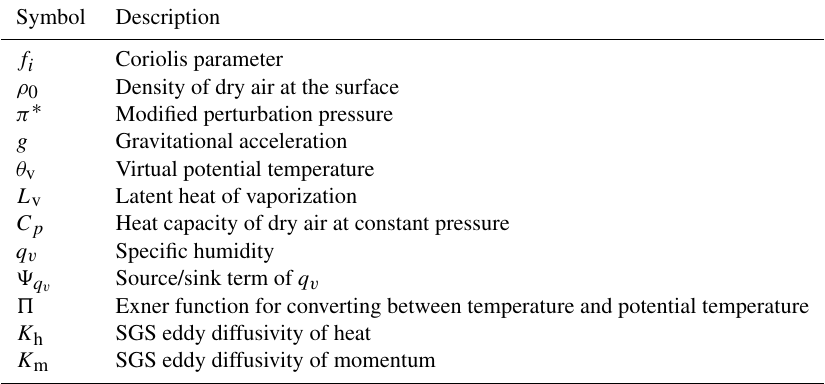
Table 1. List of symbols in the governing equations and